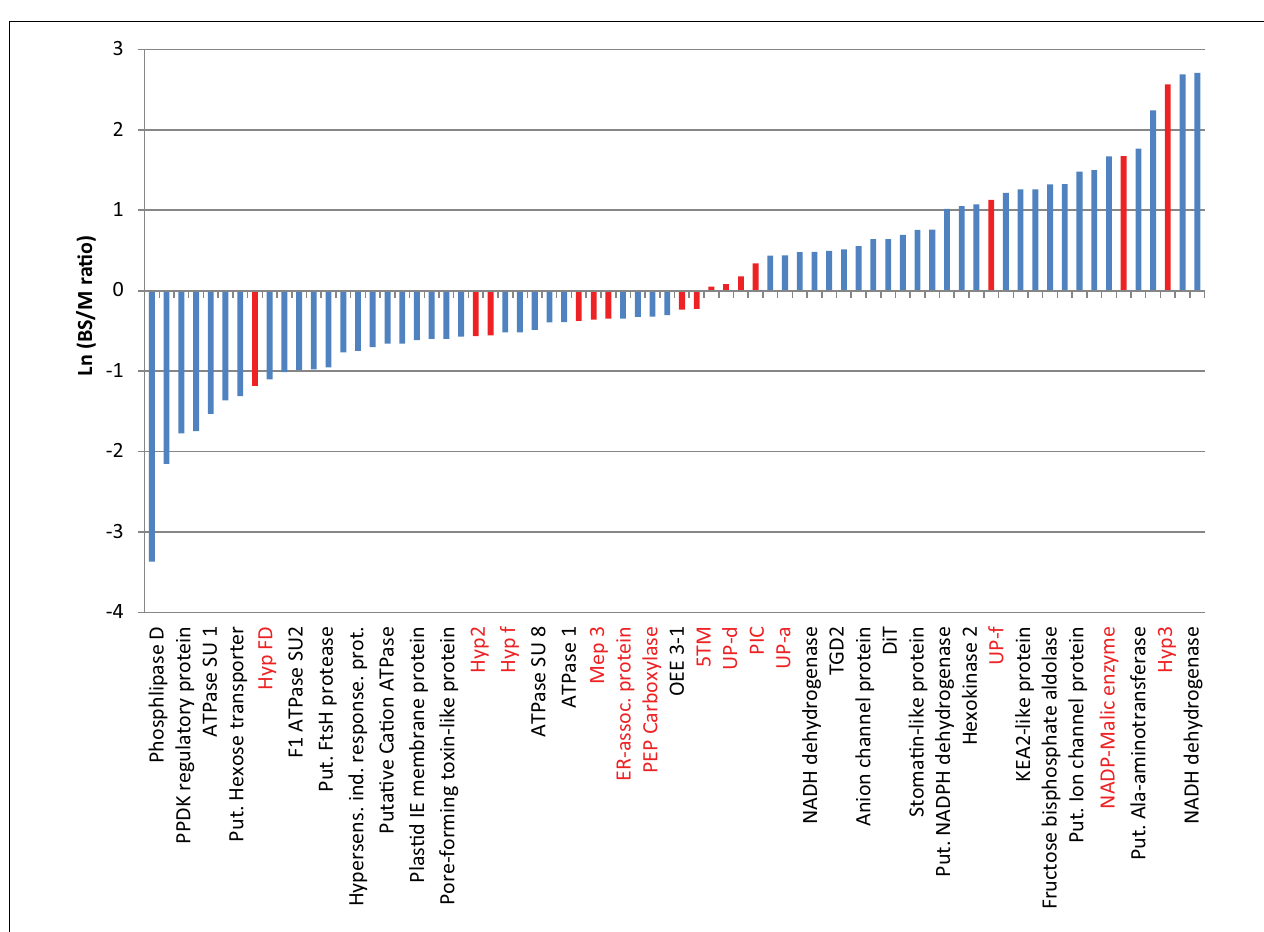
integrated. Due to space constrains only ca. 33% of the bars are labeled.The complete protein list and figure are shown inTable S4 in Supplementary Material.Values are the averages from two mesophyll and three BS data sets. Red bars indicate proteins used for further